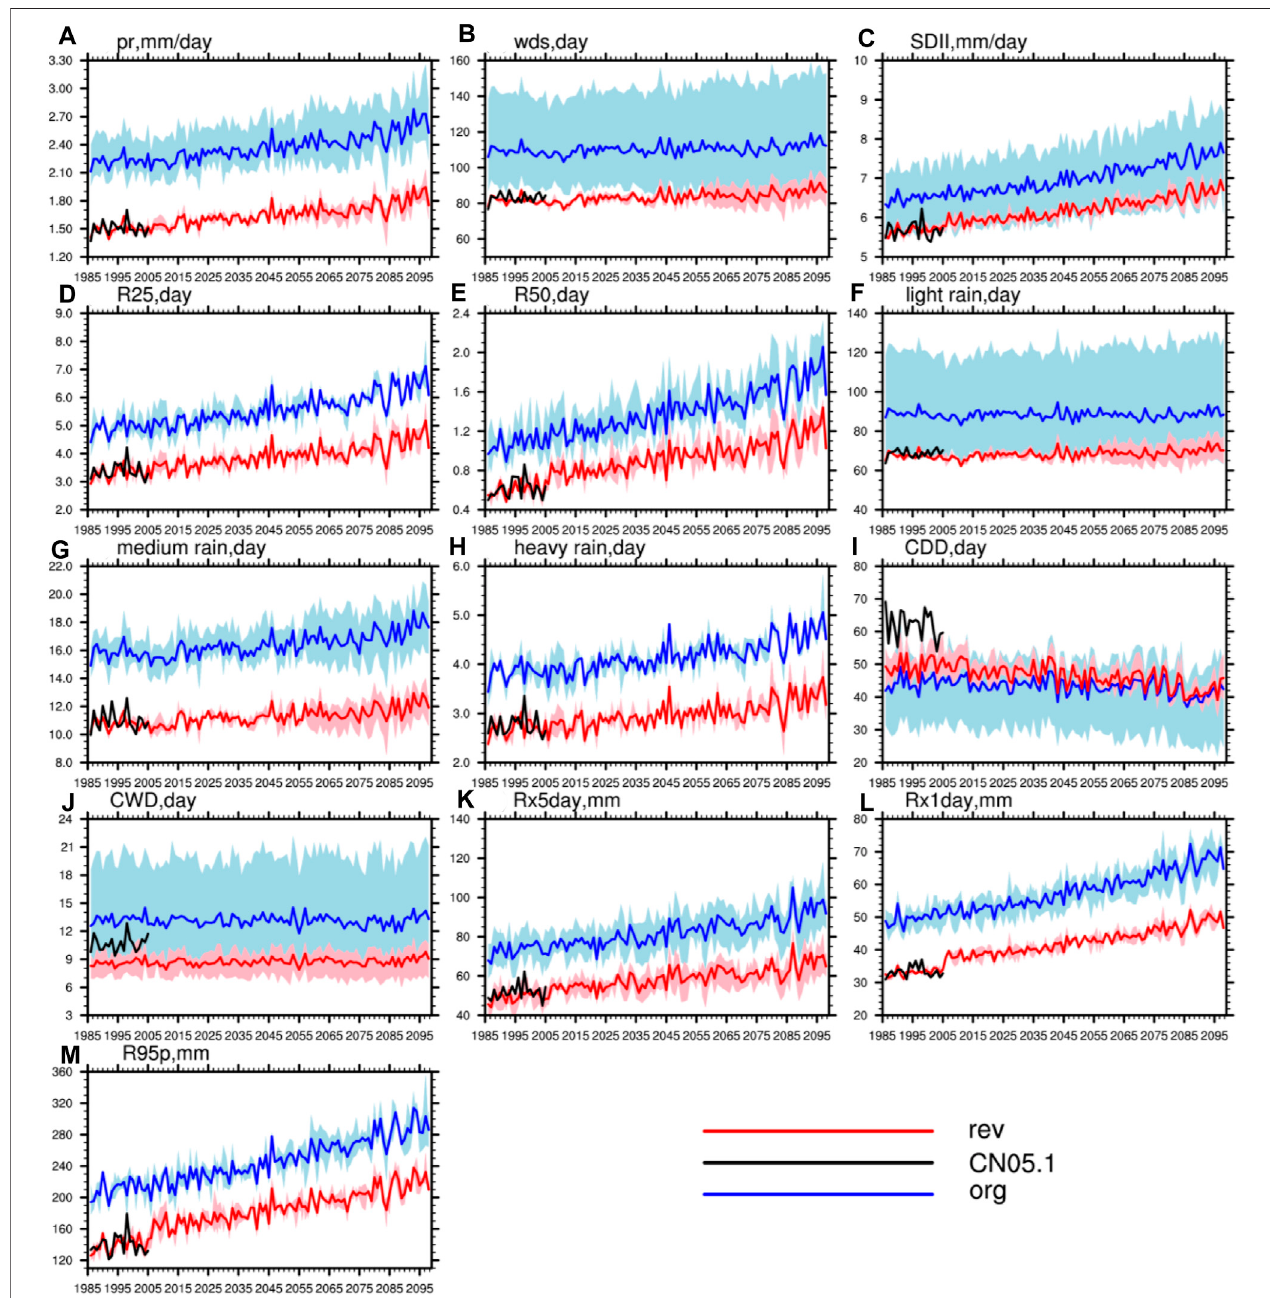
FIGURE 13 | Interannual variations of mean precipitation (A – C) , extreme precipitation (K – M) , drought indexes (I,J) and precipitation days (D – H) . The red shaded areas are the change range of simulations after correction, and the blue shaded areas present the change range of simulations before